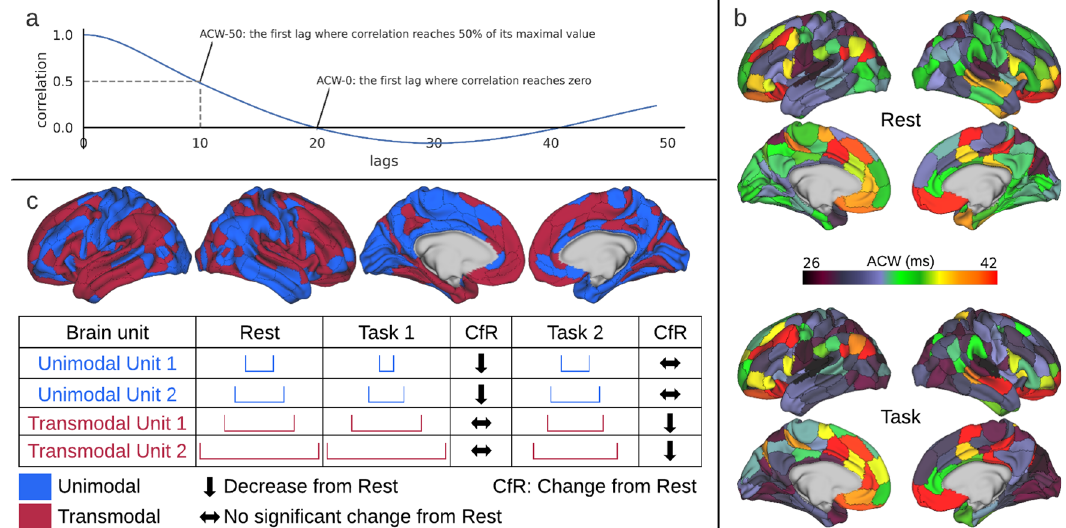
Fig. 2 Autocorrelation window (ACW) in resting and task states. a ACW is de fi ned as the fi rst lag in which the correlation of the signal with itself drops below 50% of the maximum correlation. It is measured from the autocorrelation function. b The ACW, as recorded in MEG 22 , shows topographical differences between regions during resting and task states. The colormap is in milliseconds and represents the length of ACW. c The brain map represents the uni-transmodal organization of the brain regions. The table schematically shows how ACW changes from resting to task states and also from unimodal to transmodal units in two arbitrary tasks and four sample units. The table is only for illustration purposes. Unimodal and transmodal units refers to either unimodal or transmodal regions in the brain. The numbers 1 and 2 indicate the hierarchical position (1 = lower; 2 = higher) of the respective region/unit. The blue (unimodal) and red (transmodal) intervals represent the width of their respective intrinsic neural timescales (INT) during rest and two different tasks (task 1 and 2). CfR indicates the change from rest to task with either decreasing (downward arrow), increasing (upward arrow), or maintained (horizontal double-sided arrow) width of the regions ’ INT during task relative to rest. Though schematically, the differences in the width and rest – task change of the INT during the two tasks shall indicate the fl exible and adaptive nature of the timescales as it is supported on both regional 22 and cellular 24,36,37 levels (see in rest – task overlap and rest – task modulation